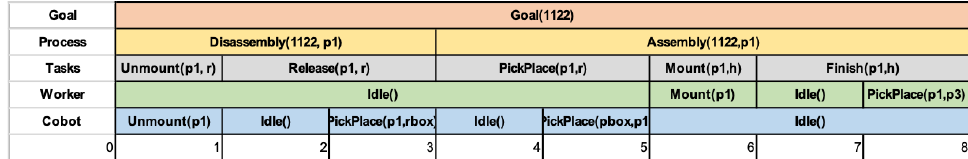
Figure 8. Simplified view of a plan synthesized for the execution of a collaborative process concerning Workpiece 1122. It shows the timelines synthesized for each state variable of the task planning model (i.e., Goal , Process , Tasks , Worker and Cobot state variables) with the scheduling of related